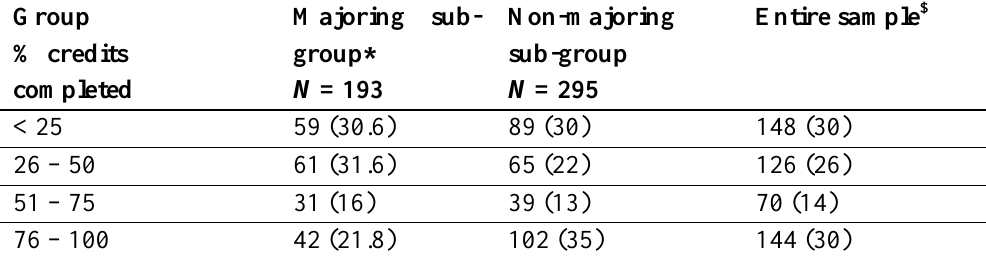
Credit Completion Status of Different Groups of Learners